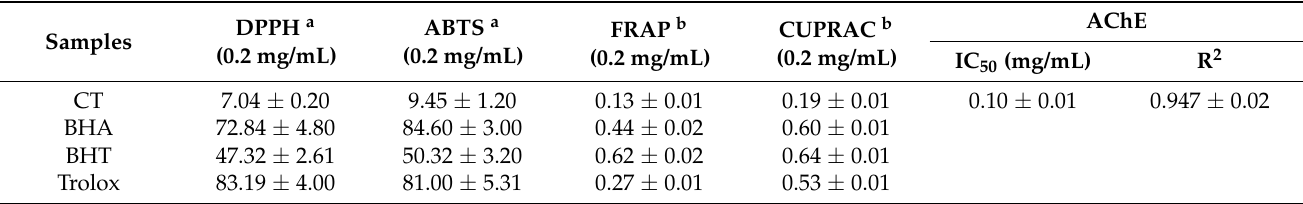
Table 2. The antioxidant and AChE inhibition properties of